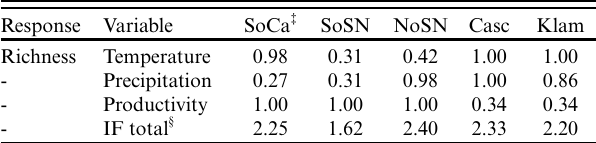
Table 3 . Impact factors † (cumulative AIC weights) indicating weight of evidence in support for different richness-structuring hypotheses for each